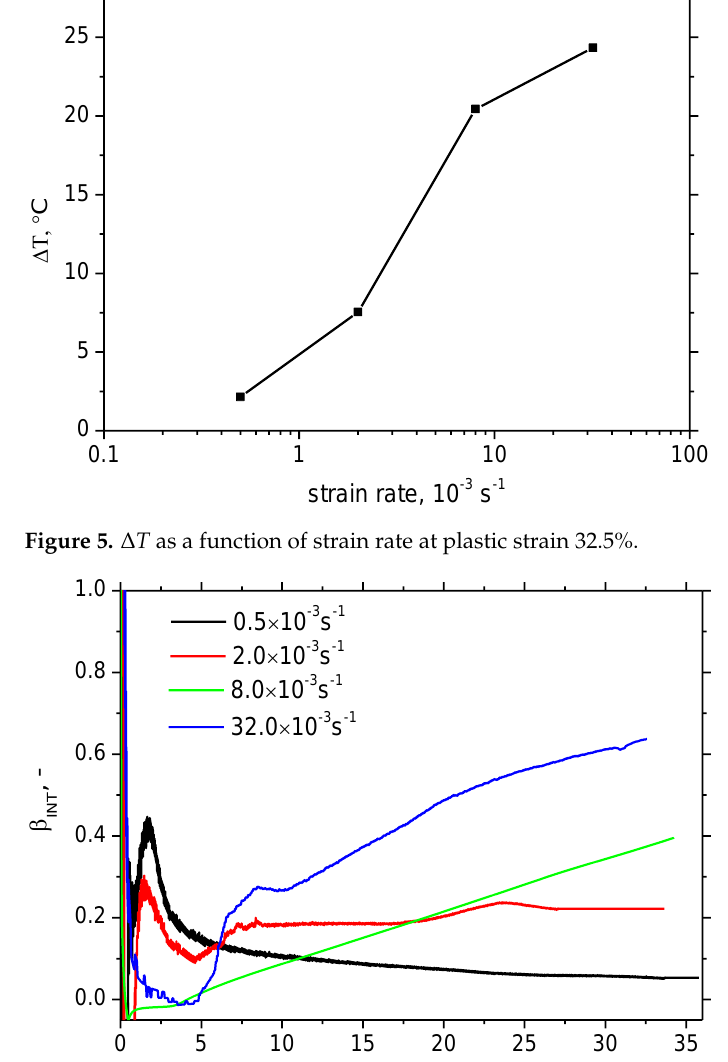
Figure 4. Evolution of temperature T as a function of plastic strain and strain rate.